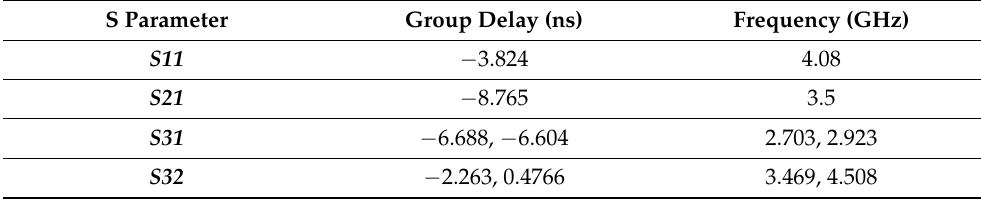
Figure 10. Current intensity distribution @ 2.84 GHz.